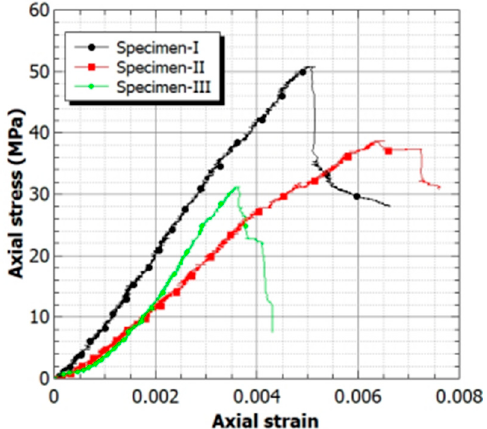
Figure 3. Relationship between axial stress and axial strain curves of tested specimens.